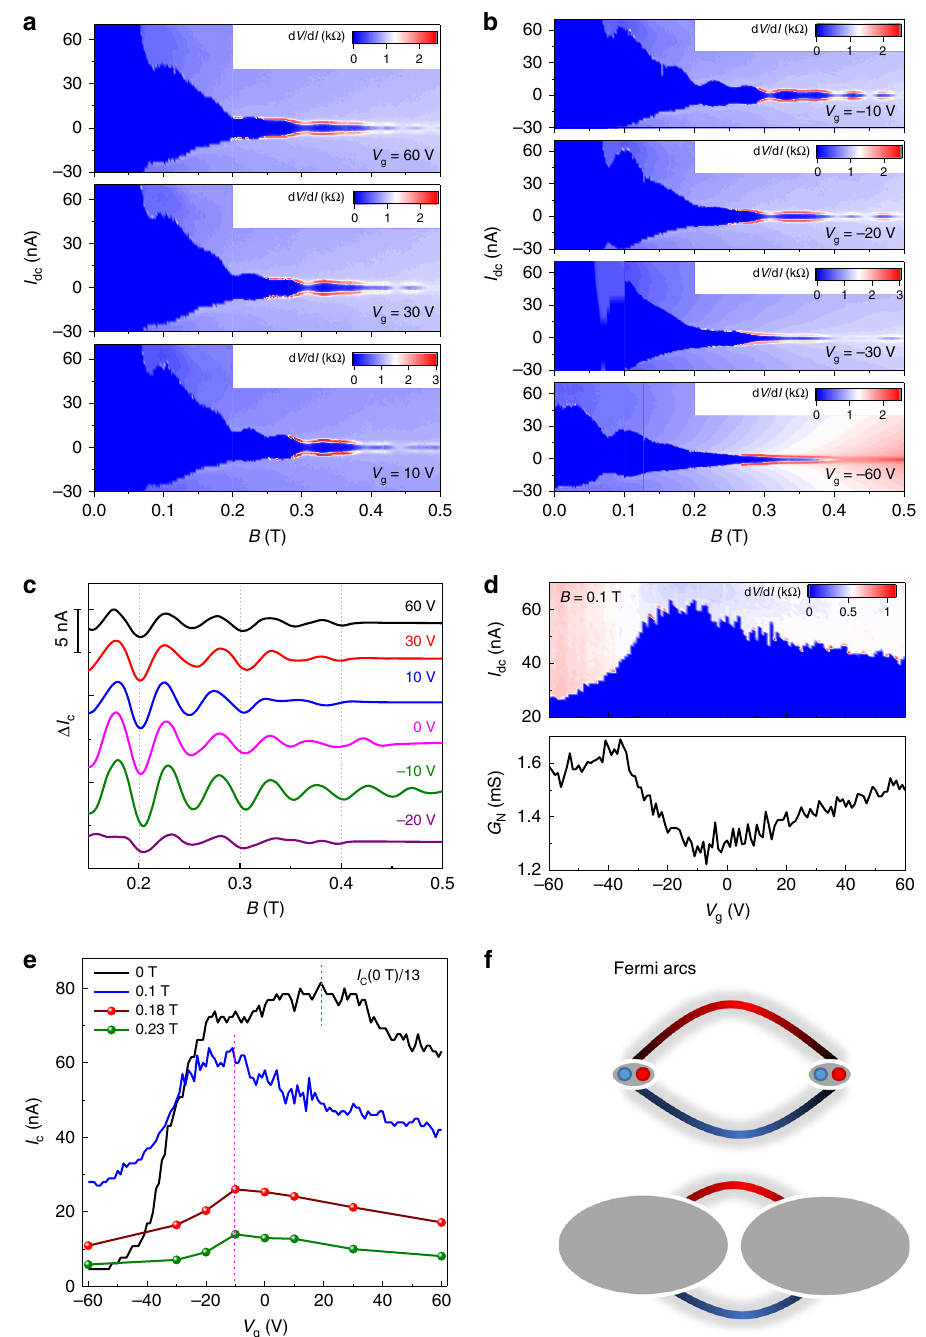
Fig. 3 Gate dependence of supercurrent oscillations. a, b Color-scale plot of d V /d I as a function of B and I dc at different V g as denoted. c The extracted Δ I c versus B at different V g . The curves have been shifted for clarity. d The comparison between critical current I c and normal-state conductance G N as a function of V g , measured at B = 0.1 T. e I c ( V g ) evolutions under different magnetic fi elds. The I c (0T) divided by 13 is shown in the fi gure. The I c (0.18T) and I I B ) peaks of the fi rst and second oscillation lobes in c , respectively. f The Fermi arcs for the Fermi level (up panel) close c ( c (0.23T) are extracted from the to and (bottom panel) away from Dirac point. The bulk Dirac points are projected on (112) crystal plane of the Cd 3 As 2